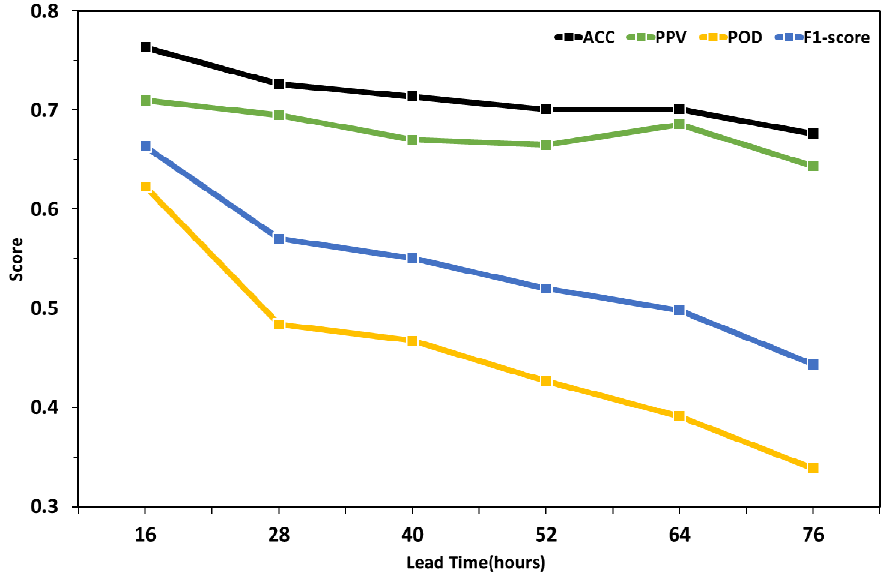
Figure 10. The ACC (black), PPV (green), POD (yellow), and F1-score (blue) along with different lead times from 16 to 76 h. The results of lead times 16, 28, 40, 52, 64, and 76 h are based on EXP-G2D2, EXP-G2D2-L2, EXP-G2D2-L3, EXP-G2D2-L4, EXP-G2D2-L5, and EXP-G2D2-L6, respectively.